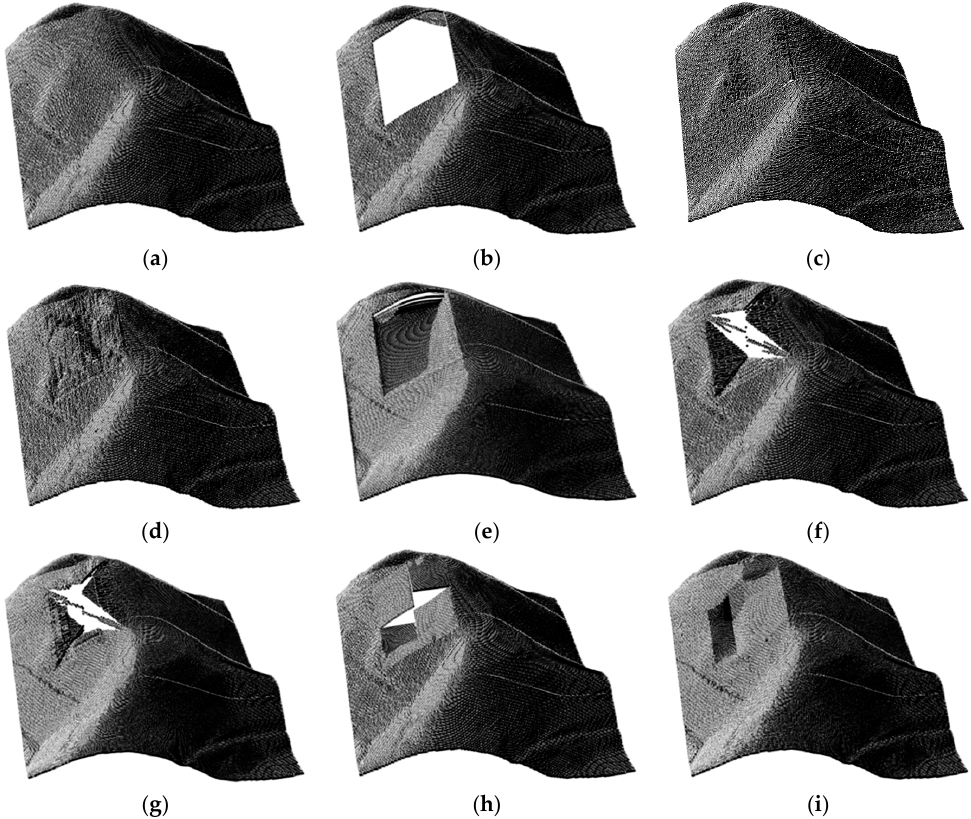
Figure 7. DEM 3D terrain filling results of a certain place in Jiangsu province (gentle terrain). ( a ) Raw